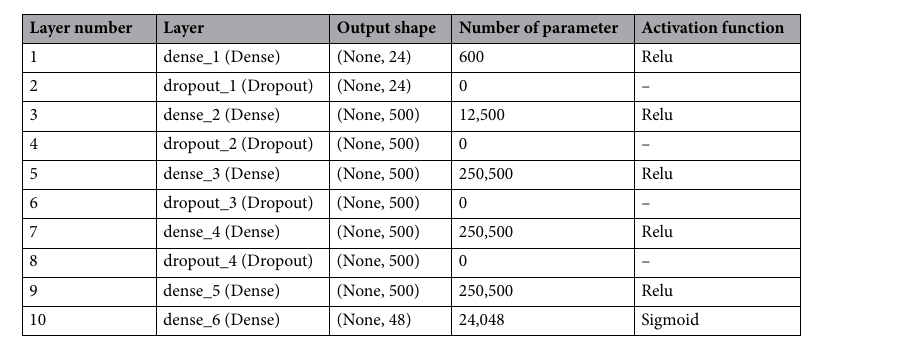
Table 2. Detailed information of the restricted output network architecture.